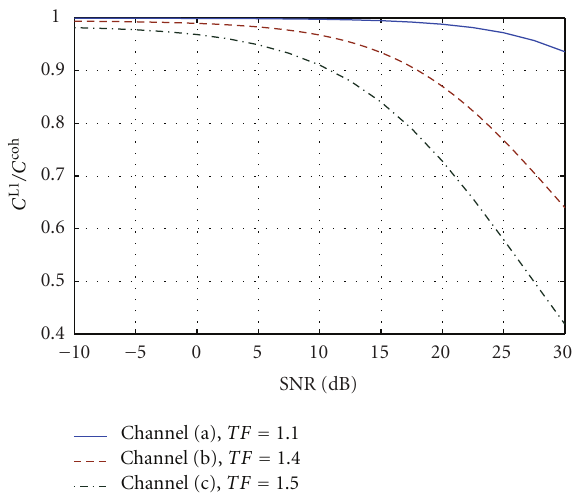
Figure 5: Lower-bound C L 1 normalized with respect to coherent information rate C coh . For each channel, TF is chosen such that there is no